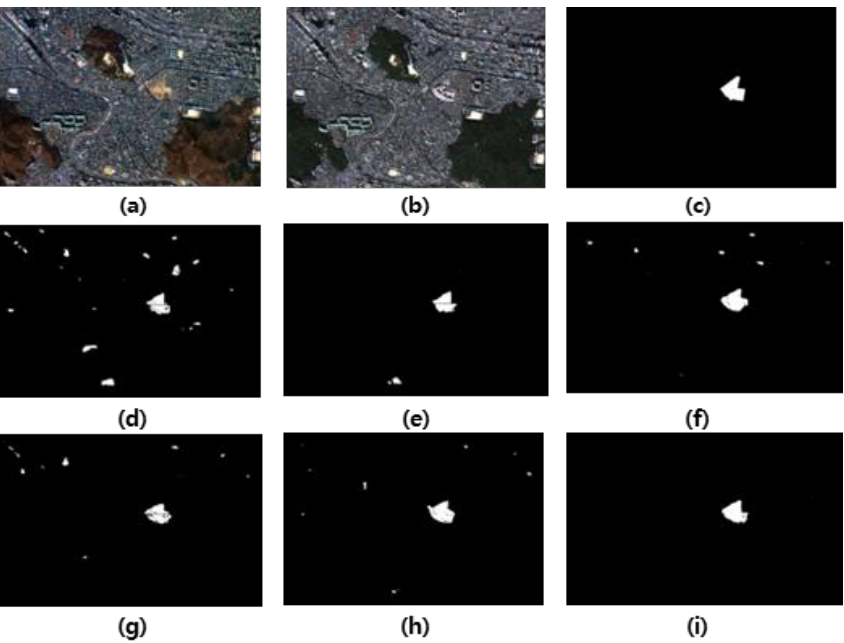
Figure 14. Changed detection maps of the proposed and conventional algorithms for “Test area 2”: ( a ) Image P; ( b ) Image C; ( c ) Ground truth; ( d ) DI + UNet; ( e ) DI + ATTUNet; ( f ) JF + UNet;